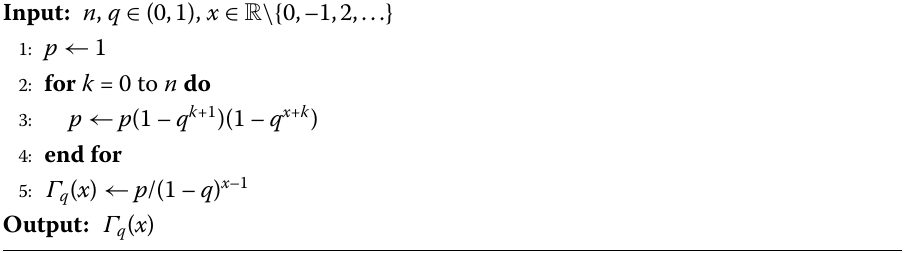
Algorithm 2 The proposed method for calculation of Γ q ( x )